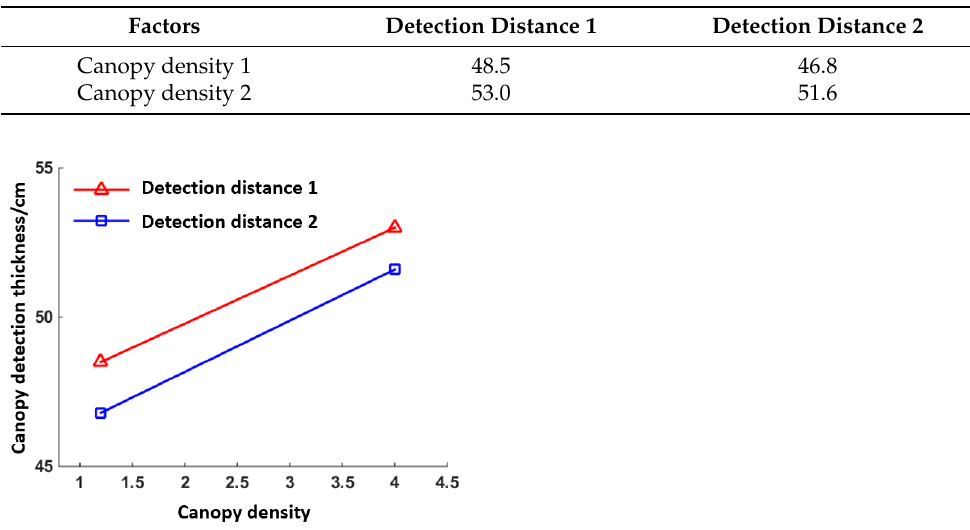
55.2 Figure 10. Diagram of the interaction between detection distance and canopy thickness. It can be seen in Figure 10 that the two lines in the graph are approximately parallel within the applicable range of canopy thickness and detection distance derived from the simulated canopy thickness detection experiment, and it can also be seen that there is no interaction between the two factors of simulated canopy thickness and detection distance